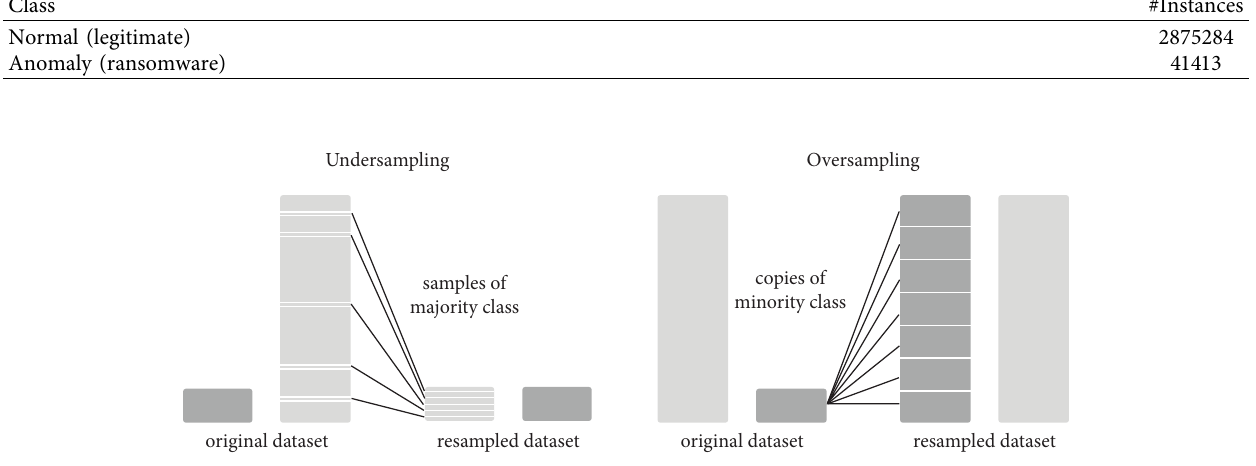
Figure 2: Random undersampling and oversampling.